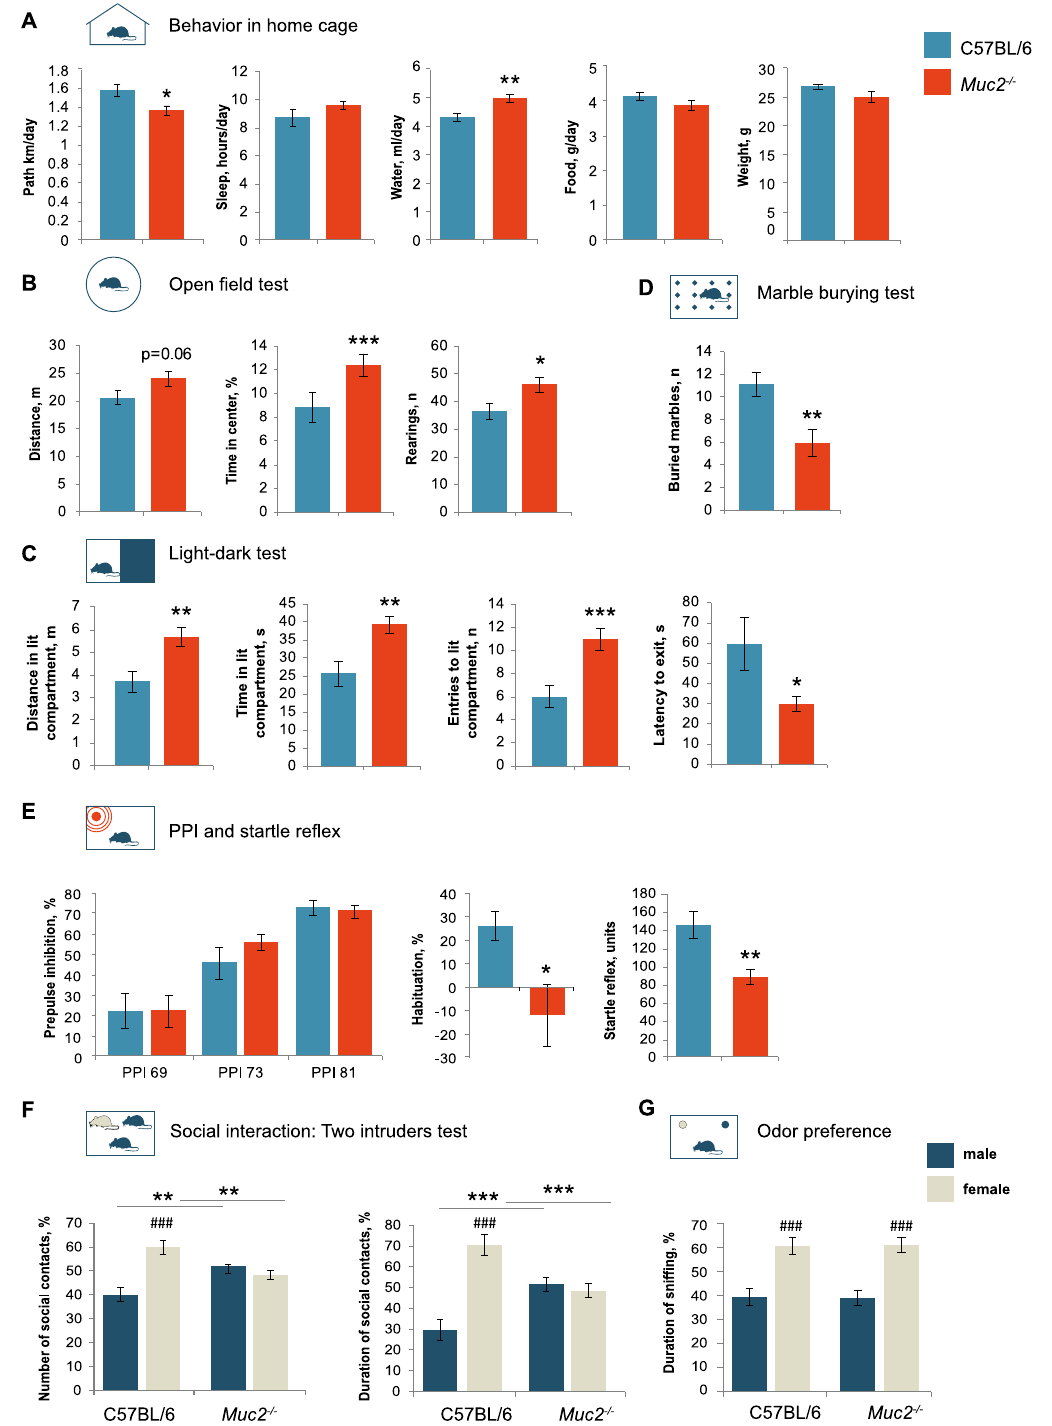
Figure 1. Behavioral traits of Muc2 −/− animals. ( A ) Behavior in home cage ( n = 9–12). Motor activity: t = 2.46, p = 0.024; water consumption rate: t = − 3.59, p = 0.002, Student’s t -test. ( B ) Open field test ( n = 18–20). Distance: t = − 1.91, p = 0.06, Student’s t -test; rearings: t = − 2.326, p = 0.026, Student’s t -test; time in the center: Z = − 3.333, p < 0.001, Mann–Whitney u test vs . C57BL/6. ( C ) Light–dark test ( n = 17–20). Distance: t = − 3.067, p = 0.004; time: t = − 3.08, p = 0.004; entries: t = − 3.66, p < 0.001, Student’s t -test. ( D ) Marble burying test ( n = 17–20). Number of buried marbles: Z = 2.93, p = 0.003; Mann–Whitney u test. ( E ) Habituation and startle reflex (n = 16–18). Startle reflex: t = 3.246, p = 0.003, Student’s t -test; habituation: Z = 2.17, p = 0.03; Mann–Whitney u test. ( F ) Two intruders test ( n = 10–11). There was a statistically significant interaction between the resident genotype and the intruder gender (number of contacts: F(1, 38) = 21.990, p < 0.001; duration: F(1, 38) = 26.045, p < 0.001, two-way ANOVA). Number of contacts (C57BL/6, male vs. female): p < 0.001, Fisher’s LSD test; duration (C57BL/6, male vs. female): p < 0.001, Fisher’s LSD test. Number of contacts with a male/female intruder vs . C57BL/6: p < 0.01, Fisher’s LSD test; duration of contact with a male/female intruder vs . C57BL/6: p < 0.001, Fisher’s LSD test. ( G ) Odor preference test ( n = 12–21). There was a statistically significant influence of the gender of animal whose odor was presented to the tested male F(1, 62) = 34.17 p < 0.001 two-way ANOVA. Duration of sniffing (male vs. female): p < 0.001, Fisher’s LSD test. * = p < 0.05, ** = p < 0.01, *** = p < 0.001, vs . C57BL/6. ### = p < 0.001, male vs .